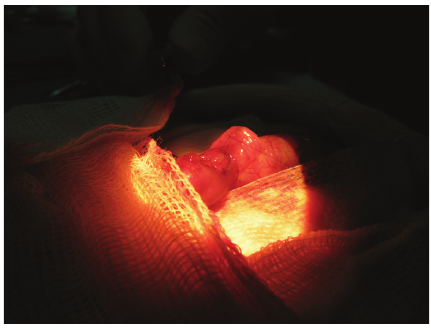
Figure 2: Intrauterine tracheal